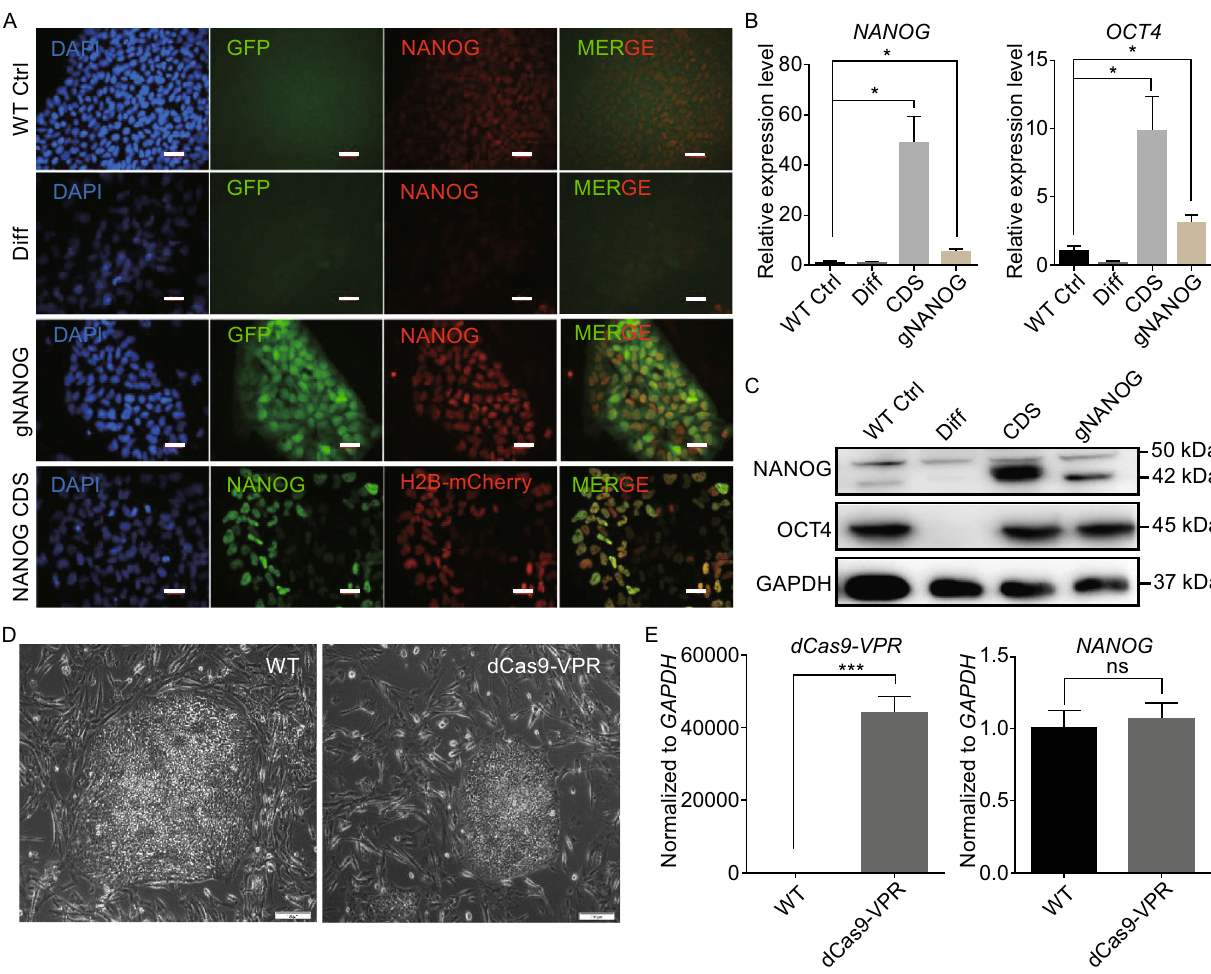
Figure 3. Activation of endogenous NANOG gene in hESCs by dCas9-VPR. (A) Immunostaining showing upregulation of NANOG protein by the dCas9-VPR system. Cells were fi xed 5 days after transfection. WT Ctrl, untransfected H9 cells; Diff, differentiated H9 cells induced by 10 μ mol/L retinoic acid (RA); gNANOG, H9 cells co-transfected with dCas9-VPR and gNANOG plasmids; NANOG CDS, cells co-transfected with CAG-rtTA and TRE driving NANOG-2A-H2B-mCherry. Dox were added immediately after electroporation. All plasmids were based on the PiggyBac system and co-transfected with a plasmid containing HyperPB transposase driven by a CAG promoter. Scale bar, 20 μ m. (B) Q-PCR analysis of NANOG and O CT4 expression in H9 cells 5 days after transfection. All expression levels normalized against GAPDH . Error bars represent SEM. * P < 0.05 , n = 3. (C) Western blot analysis of NANOG and OCT4 protein expression in H9 hESCs. Cells were harvested 5 days after transfection without selection. (D) DCas9-VPR constitutive expressing H9 cells showed similar clone morphology after long-term culture. Scale bar, 100 μ m. (E) Q-PCR result showing dCas9-VPR constitutive expressing H9 cells and wild-type H9 cells expressed similar amount of NANOG . All expression levels normalized against GAPDH . Error bars represent SEM. ns. P > 0.05, *** P < 0.001, n =